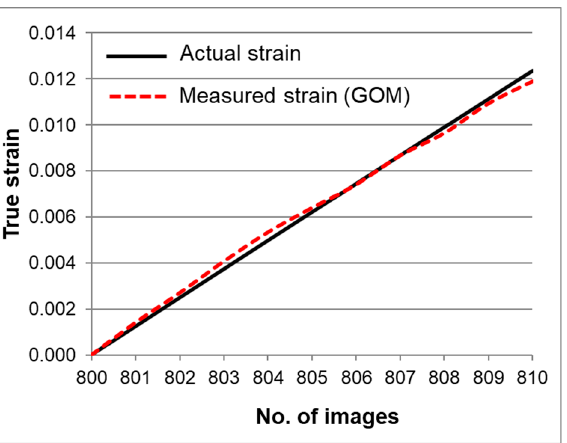
Figure 7. Comparison of the actual and measured strains (using GOM software) in the images with known and uniformly distributed strains.